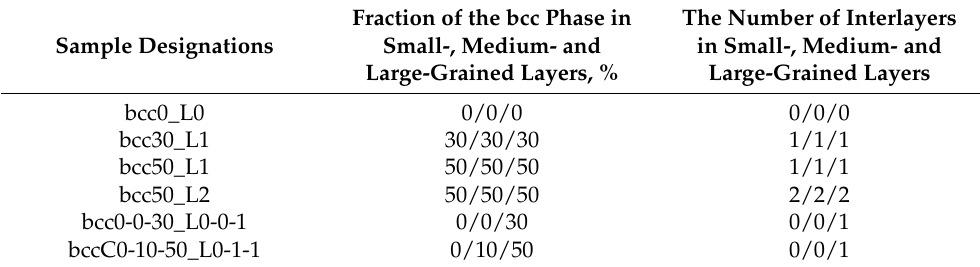
Table 1. Designations and characteristics of the simulated